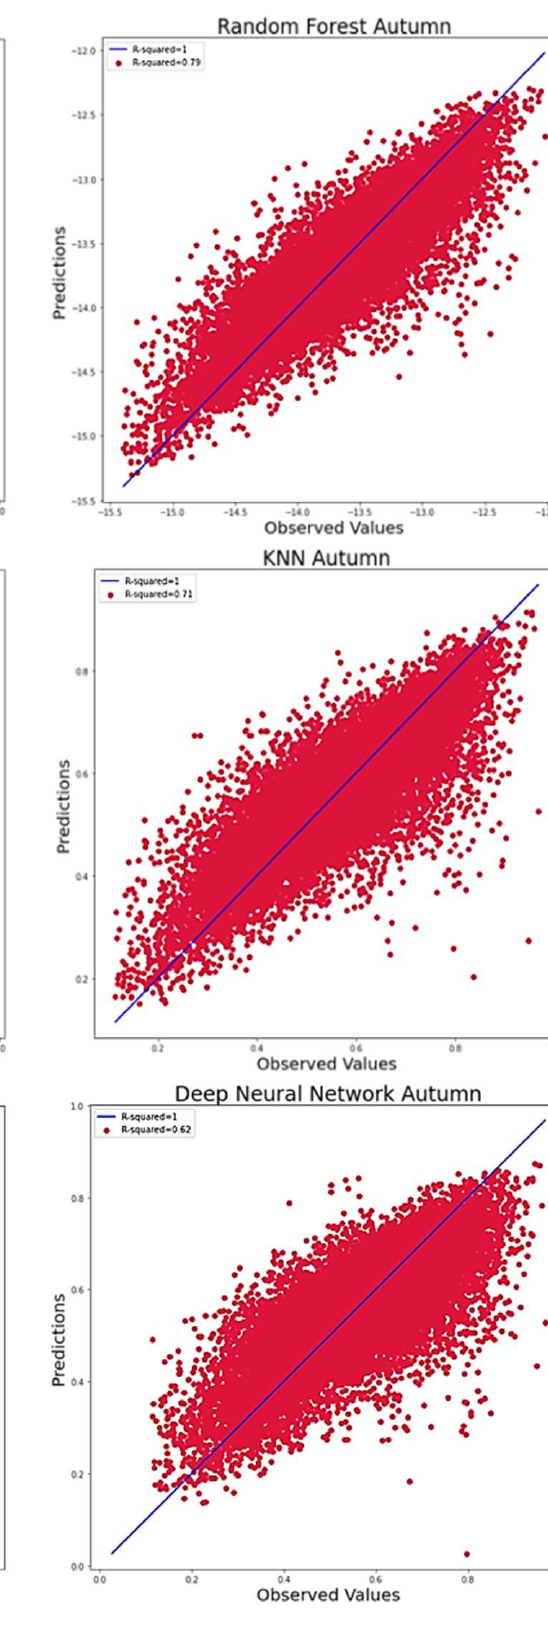
Figure 5. Scattering plots of the six ML algorithms for the autumn data set.